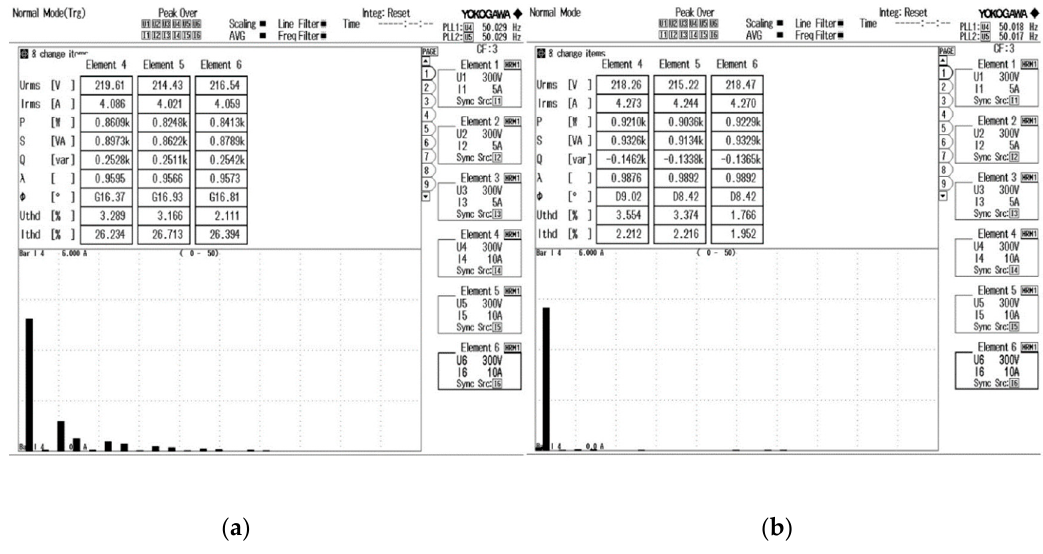
Figure 13. FFT spectrum of source current ( a ) before compensation and ( b ) after compensation.